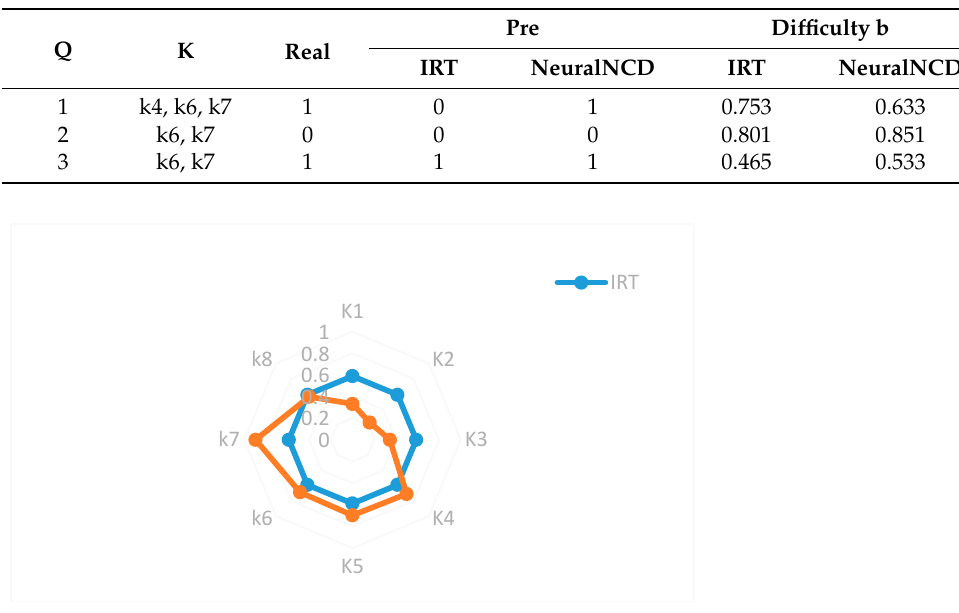
Figure 4. Case study diagram.